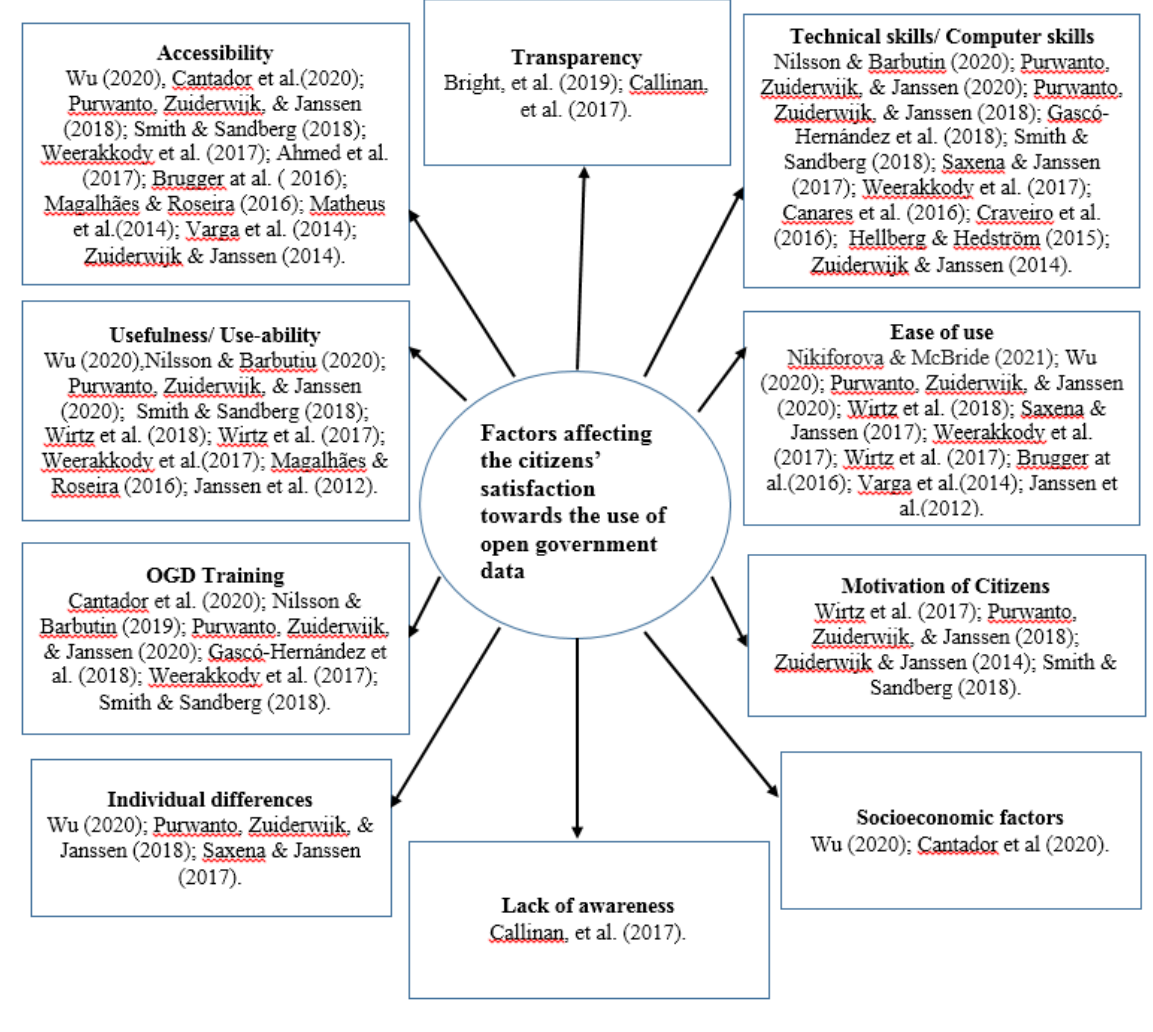
Figure 4: Factors Affecting the Citizens’ Satisfaction with the Use of